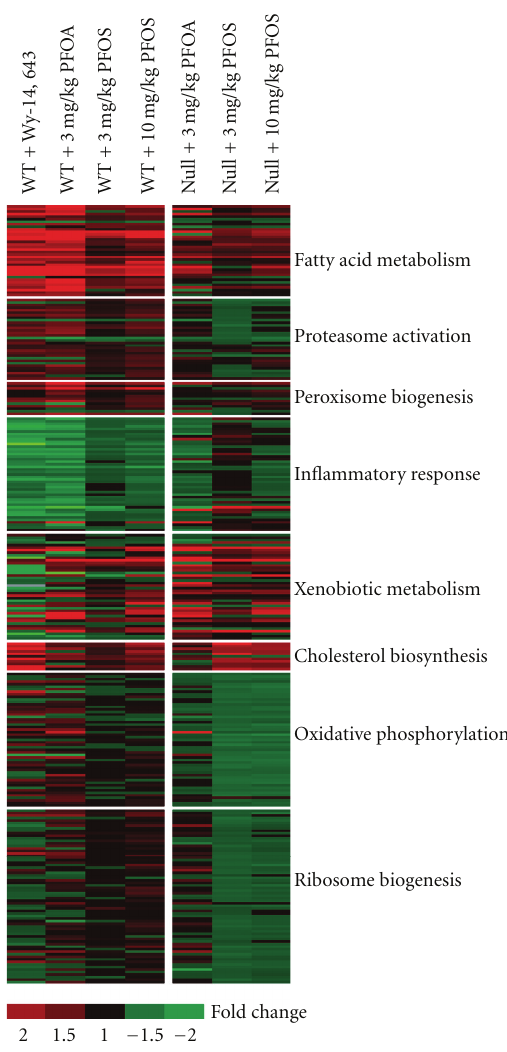
Figure 3: Functional categories of genes modified by PFOS in WT and Null mice. In WT mice, PFOS altered the expression of genes related to a variety of PPAR α -regulated functions including lipid metabolism, peroxisome biogenesis, proteasome activation, and the inflammatory response. Genes a ff ected in both WT and Null mice consisted of transcripts related to lipid metabolism, inflammation, and xenobiotic metabolism. Several categories of genes were uniquely regulated by PFOS in Null mice including up-regulation of genes in the cholesterol biosynthesis pathway as well as modest down-regulation of genes associated with oxidative phosphorylation and ribosome biogenesis. Red or green corresponds to average up- or down- regulation,